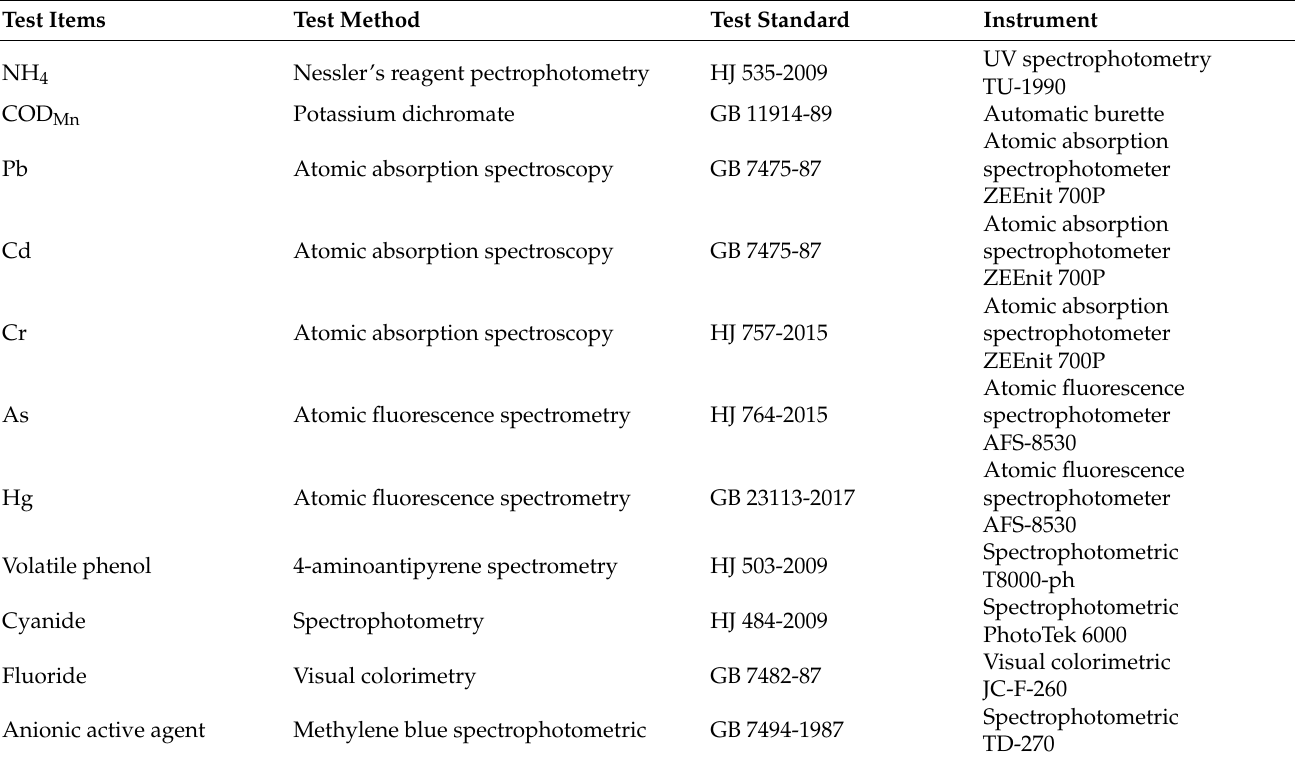
Table 2. Testing methods and instruments for the water quality